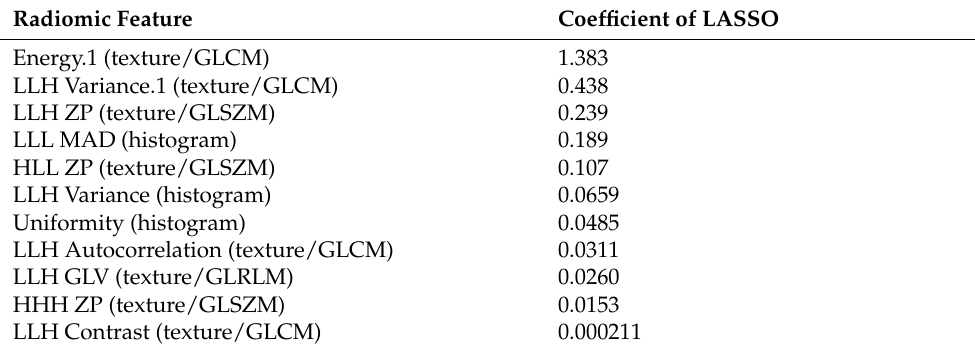
Table 2. Eleven radiomic features with their coefficients selected by LASSO. All abbreviations are explained in Table S1.